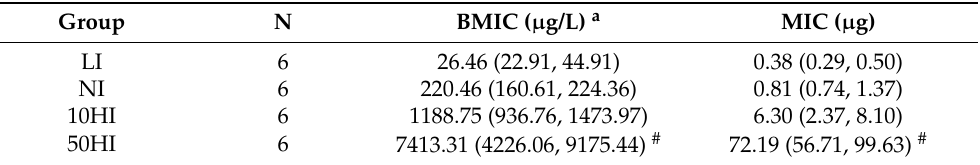
Table 2. Breast milk iodine concentration and mammary gland iodine content of maternal rats on PND14. Group